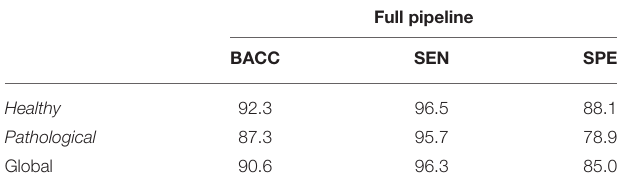
TABLE 5 | Full pipeline